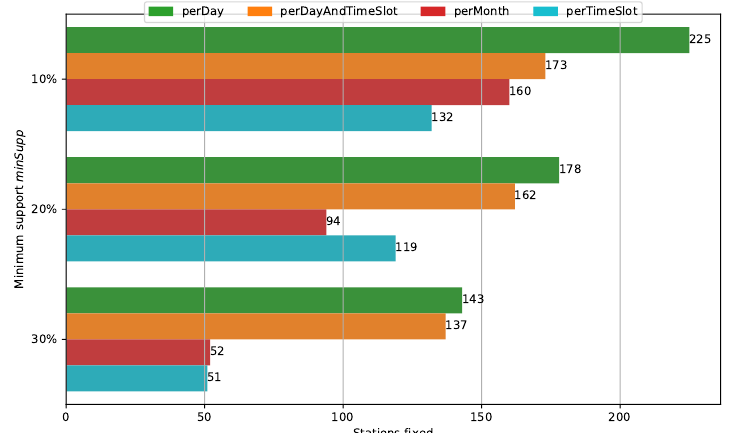
Figure 9. Number of fixed stations with varying minSupport .